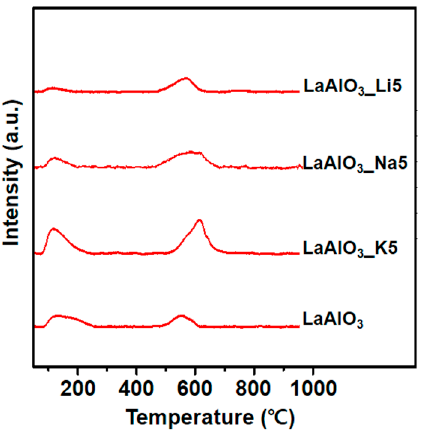
Figure 6. CO 2 -TPD profile of LaAlO 3 _X5 (X = Li, Na, K) and LaAlO 3 catalysts. Table 4. Peak areas of LaAlO 3 _X5 (X = Li, Na, K) and LaAlO 3 catalysts calculated from CO 2 -TPD profiles. Catalyst LaAlO 3